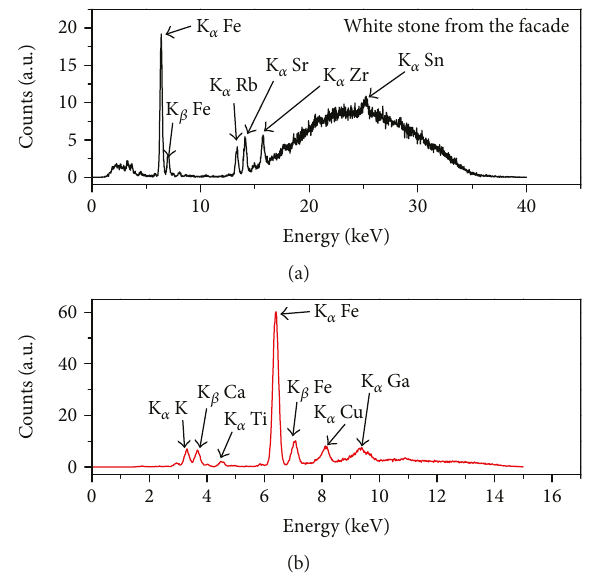
Figure 14: XRF spectra, in the 0 – 40keV range (a) and 0 – 16 keV range (b), of a white stone from the facade of the Abbey of SS. Pietro e Paolo d ’ Agrò.